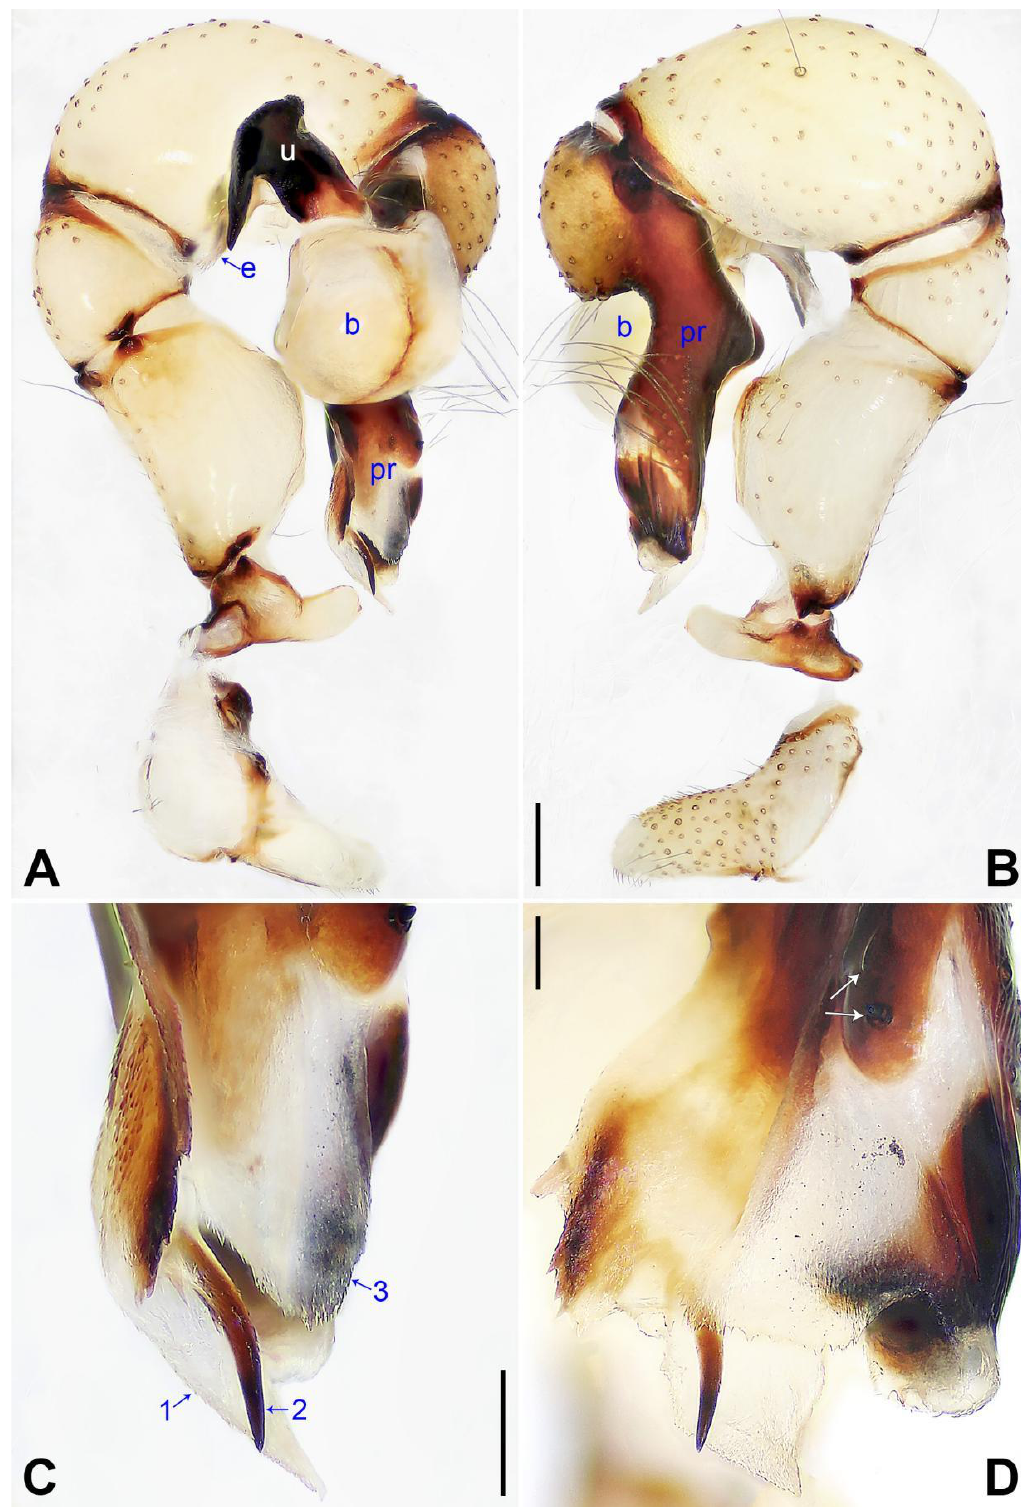
Figure 9. Pholcus luliang sp. nov., holotype male: ( A ) pedipalp, prolateral view; ( B ) pedipalp, retrolateral view; ( C ) distal part of procursus, prolateral view (arrow 1 pointed at prolateral membranous process, arrow 2 pointed at spine-shaped distal apophysis, arrow 3 pointed at dorsal membranous lamella); ( D ) distal part of procursus, dorsal view (arrows point at dorsal spines). b = bulb, e = embolus, pr = procursus, u = uncus. Scale bars: ( A , B ) = 0.20 mm; ( C , D ) = 0.10 mm.